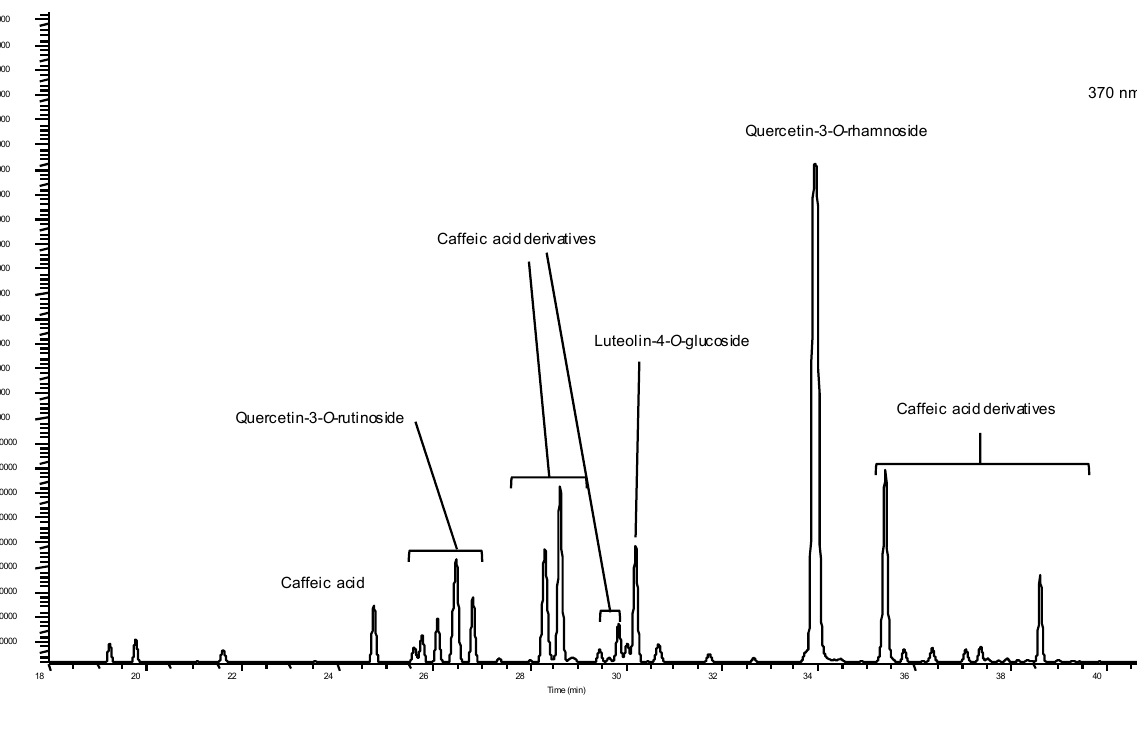
Figure 1. Example of a HPLC chromatogram of polyphenols detected in a red lettuce baby-leaf extract recorded at 370